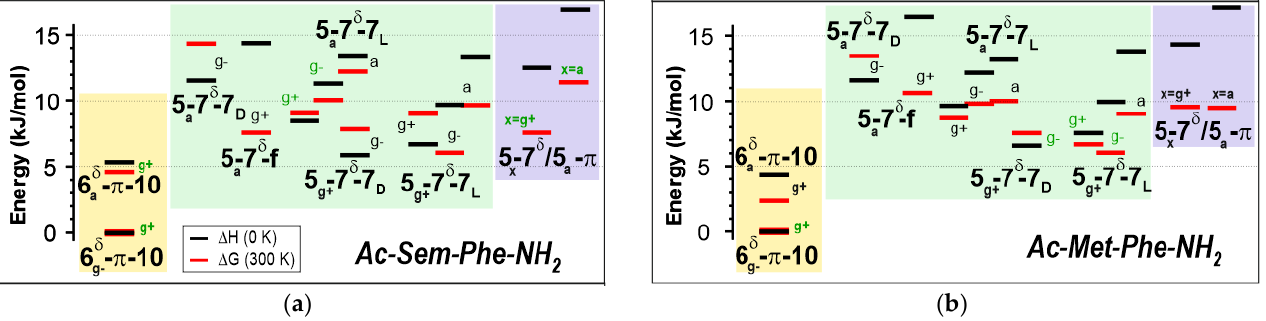
Figure 2. Conformational landscape of Sem-Phe (left panel; ( a )) and Met-Phe (right panel; ( b )) peptide chains, obtained at the RI-B97-D3(BJ-abc)/def2-TZVPPD level of theory. The 0 K ∆ H relative energies (resp. 300 K Gibbs energies, ∆ G) are given as black (resp. red) lines. The conformation labels refer to the sequential status of the N–H bonds along the backbone (see text). The g +/ g − / a subscripts of the folded and semi-extended conformations refer to the χ 3 dihedral of the Sem/Met side-chain; the labels associated with the bar of each conformation refer to Phe side-chain χ 1 orientation ( g +/ g − / a ). In the extended conformation family, the x label refers to the Sem/Met side-chain χ 3 dihedral. Green labels indicate conformations, which are consistent with experimental